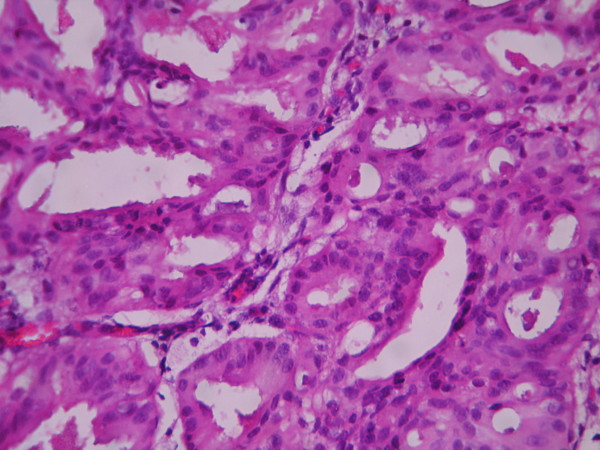
Endometrial adenocarcinoma. The glands show cribriform bridging. (High power)